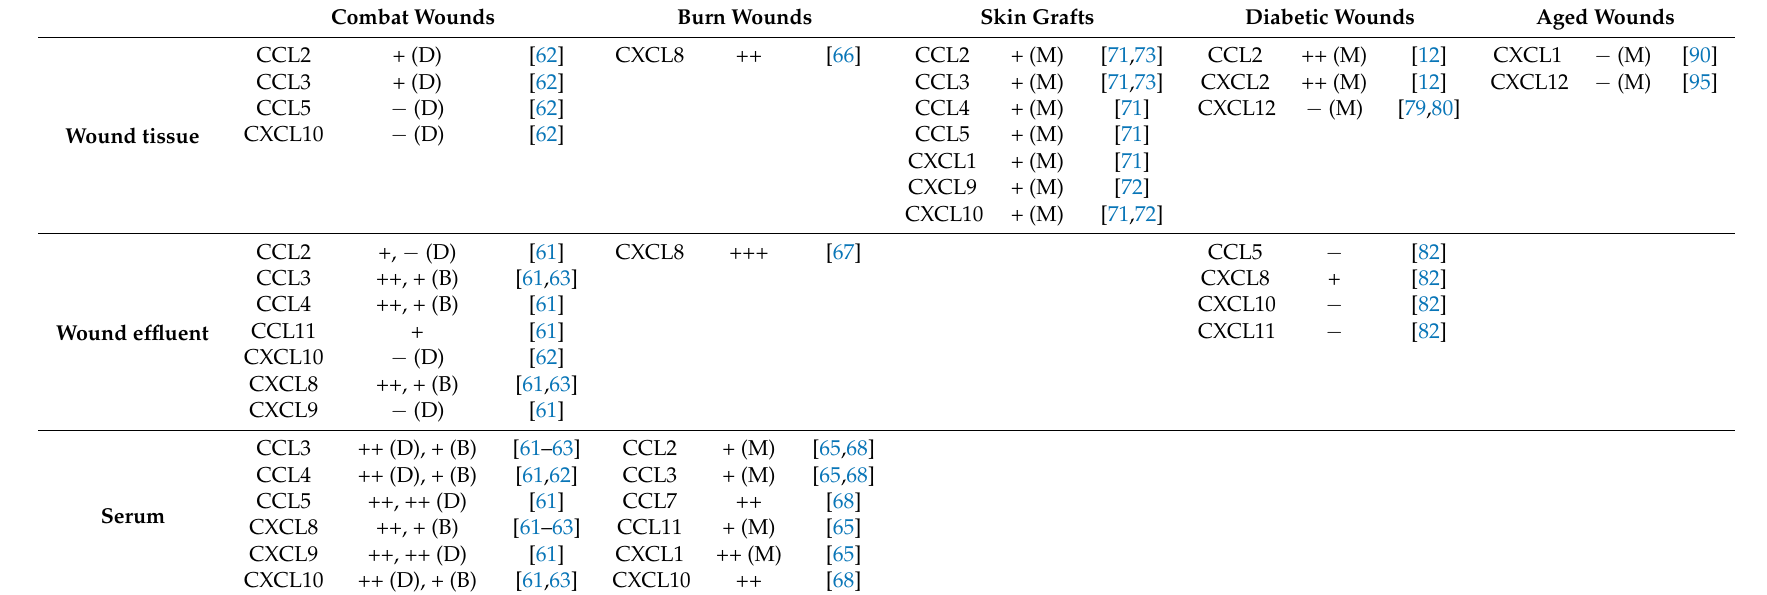
Table 2. Relative chemokine expression in different wound